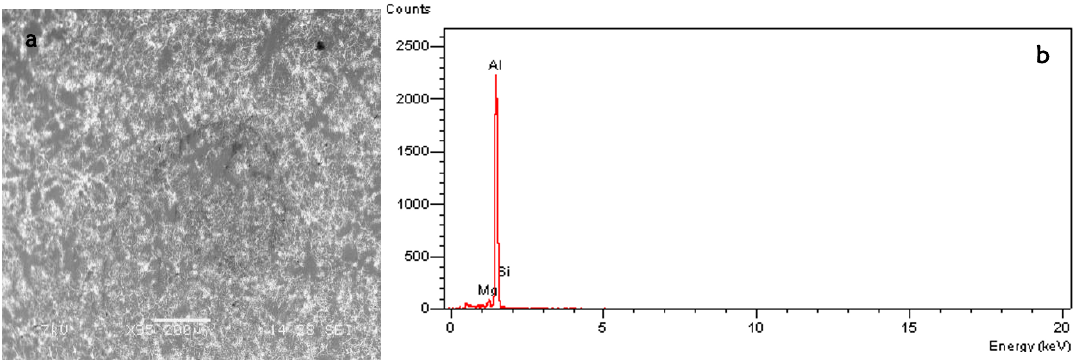
Figure 2: (a) Scanning electron micrograph (b) energy dispersive x-ray spectroscopy of 6061Al alloy.